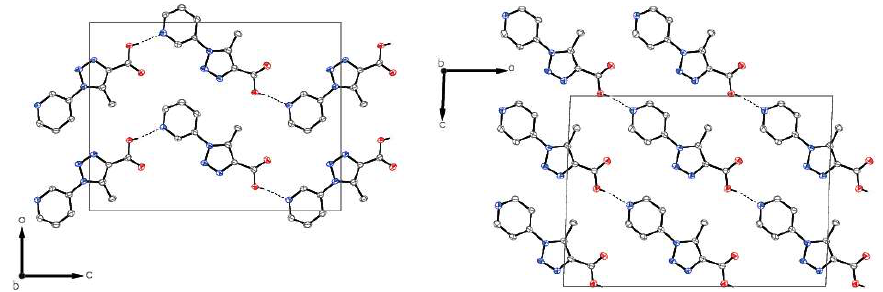
Figure 2. Crystal packing of compound L1H ( left ) and L2H ( right ).